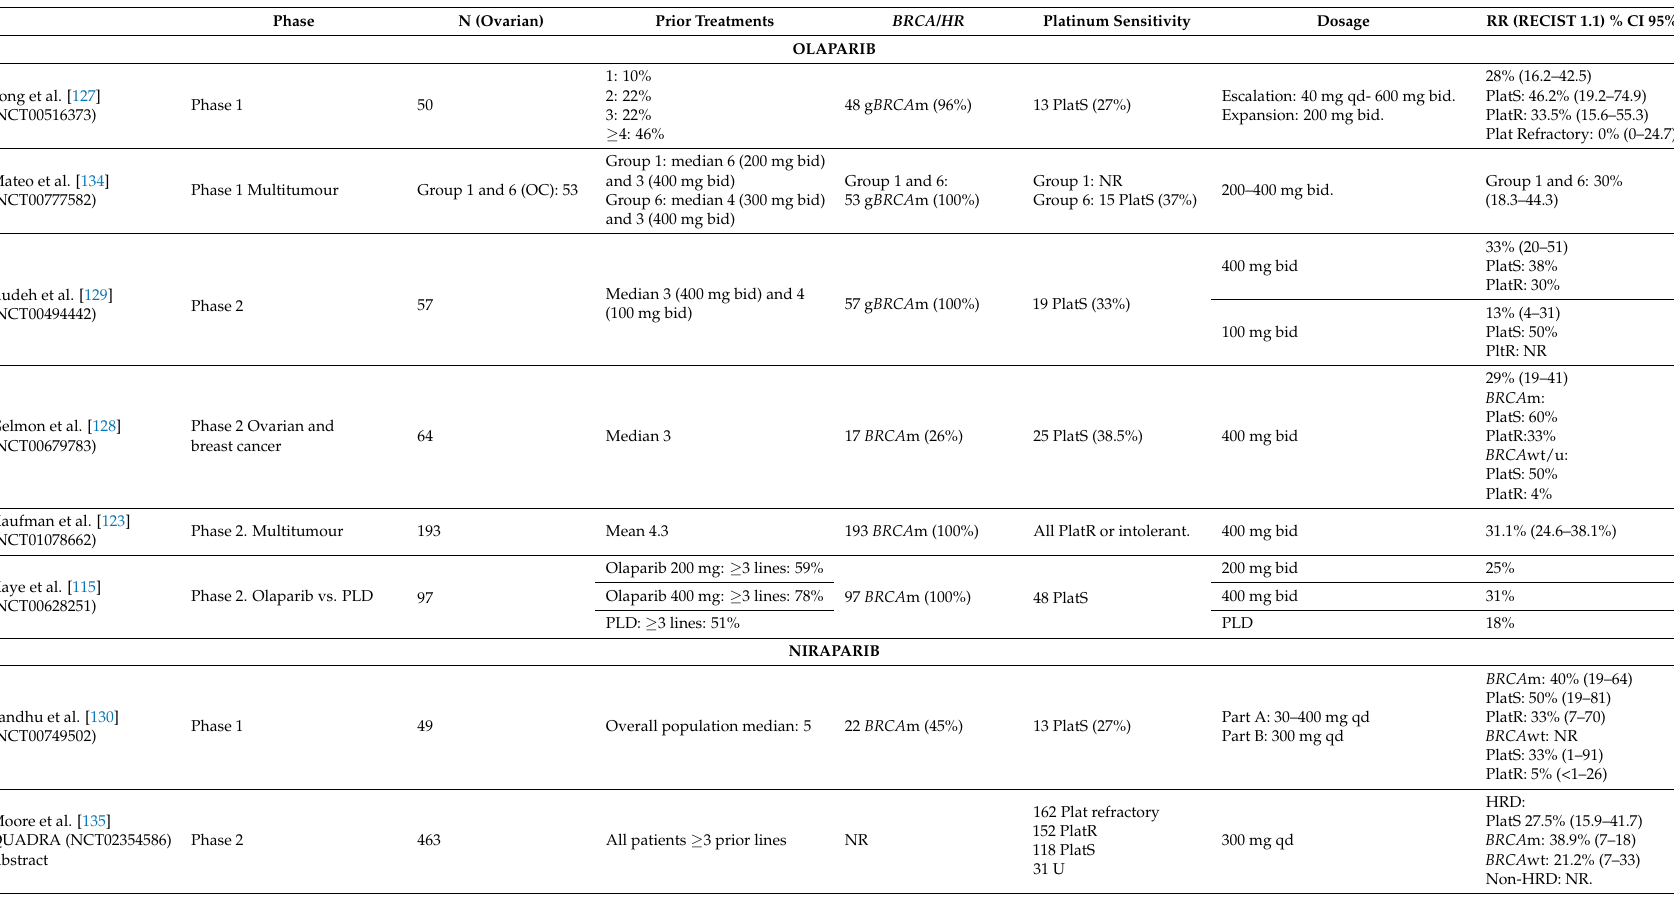
Table 1. Phase 1–2 trials assessing single agent PARP inhibitors. N: number of patients. NR: Not reported. PlatS: platinum sensitive. PlatR: platinum resistant. BID: twice daily. QD: Once daily. LOHh: High loss of heterozygosity, LOHl: Low loss of heterozygosity; LOHu: Unkown loss of heterozygosity. MMC: MitomicinC. IV: intra venous. PFI: platinum free